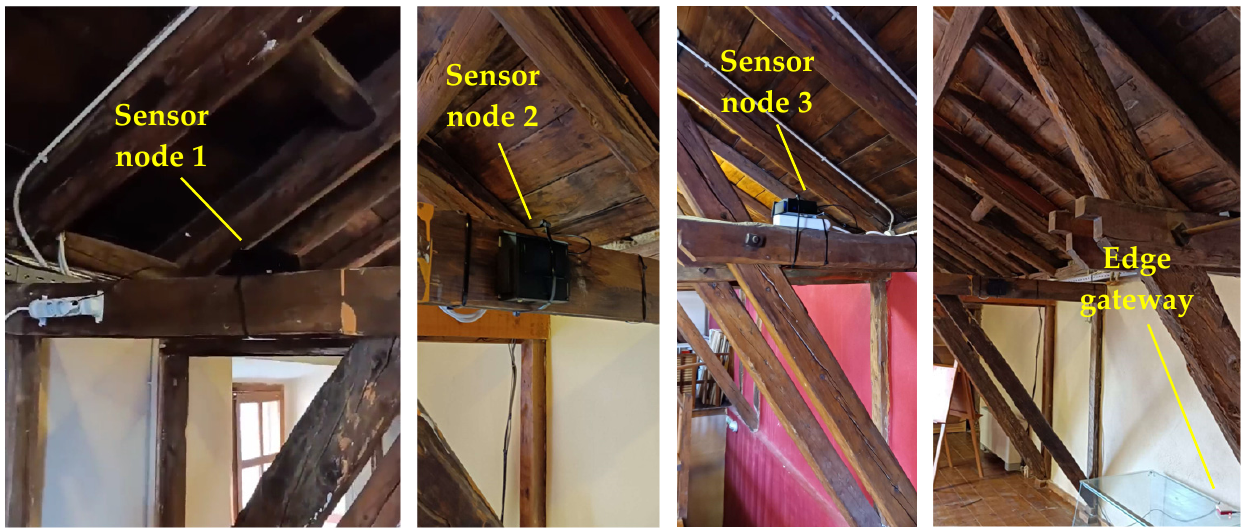
Figure 13. Installation of SB112 system into a building of interest for continuous operation and 565 monitoring.